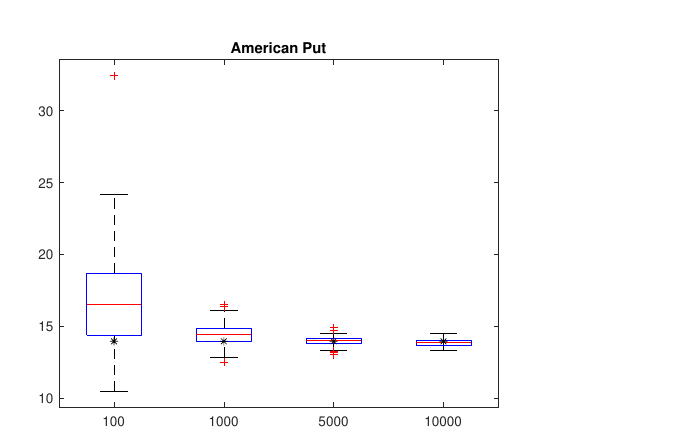
Figure 6. Bootstrapping for OEX put option with time to maturity of T = 31 days and strike price K = 910. Figure 7 provides a graphical illustration of the calibration for 6 April 2016. Calibrated CGMYSV prices are drawn by " × ", the market observed prices are drawn by " ◦ ", and the 95% confidence intervals are marked by a "I" shape. The days to maturities T are written on the